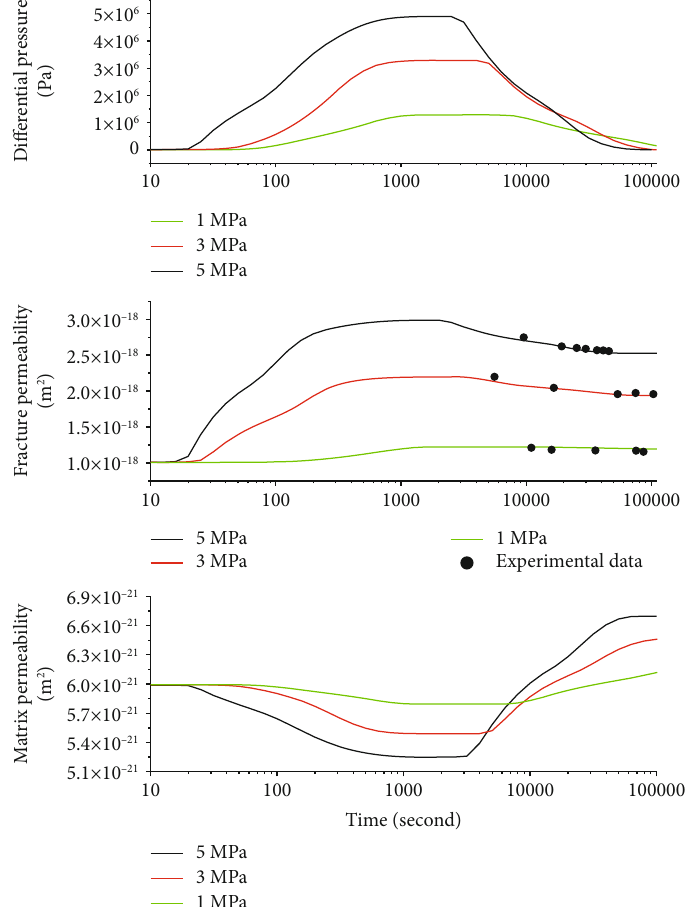
Figure 11: Modeling gas pressure and permeability evolutions of cleat and matrix under constant con fi ning stress